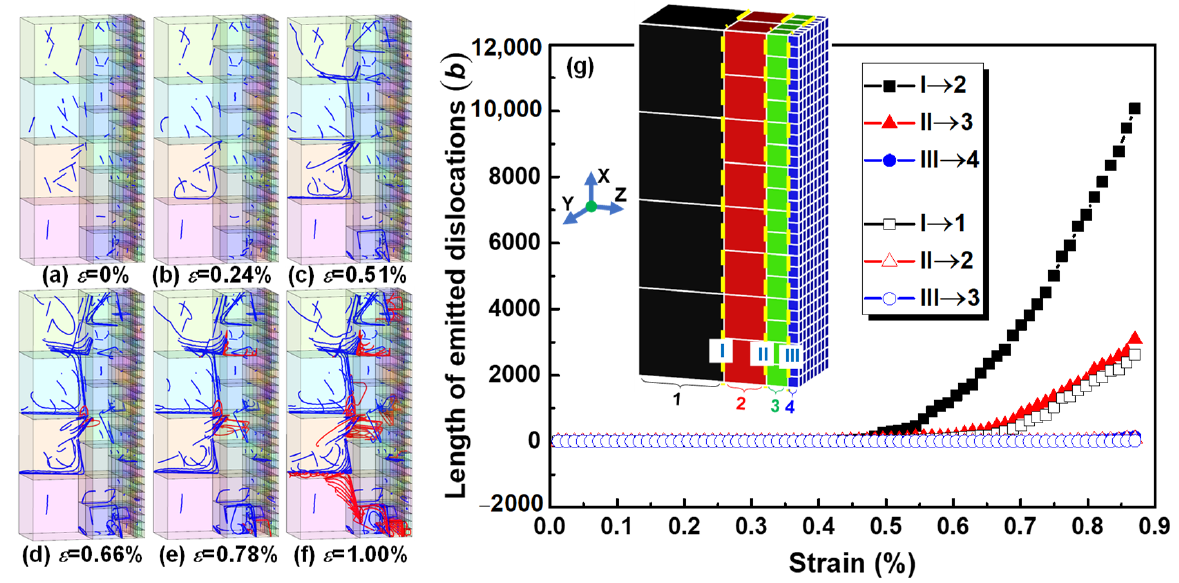
Figure 4. ( a – f ) Dislocation structures at different applied strains for the GNG sample. The dislocation lines activated from initial dislocation sources are colored blue, while the red lines indicate the ones emitted from grain boundaries. ( g ) The length of emitted dislocations from different layer interfaces to different layer interiors; the insert shows the positions of four “layers” (1, 2, 3 and 4) and three “interfaces” (I, II and III). The legend labeled “I → 2” in the plot means dislocations emit from Interface-I into Layer-2; the meanings of other labels are the same.